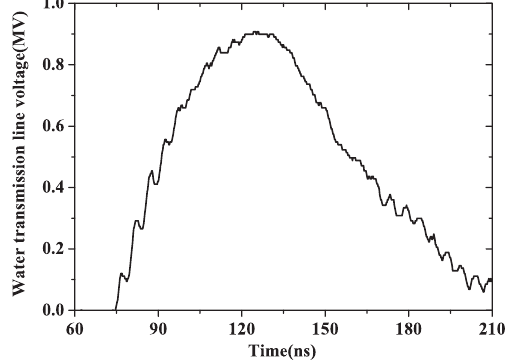
FIG. 8. The forward-going voltage wave traveling in the water transmission line measured by a D-dot monitor placed at the front of the water transmission line. The peak value of the voltage pulse is about 0.9 MV.